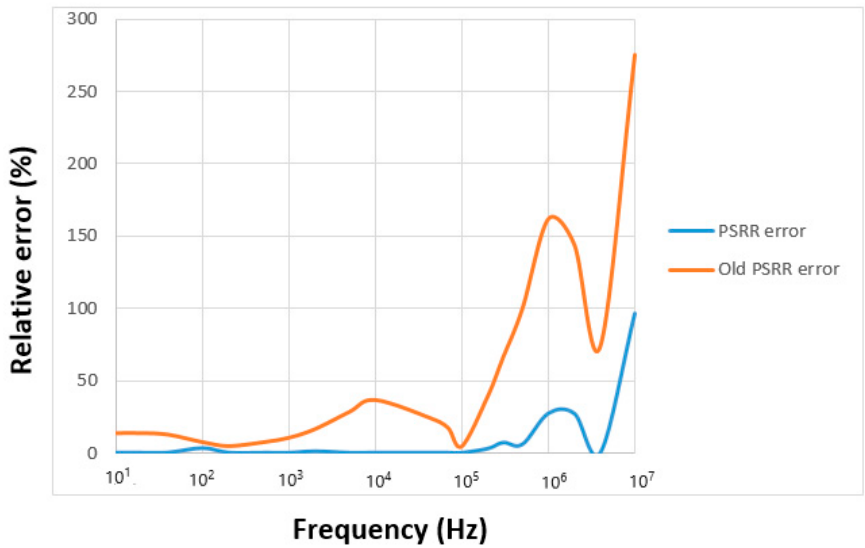
Figure 18. Original PSRR approach and new PSSR approach relative errors.